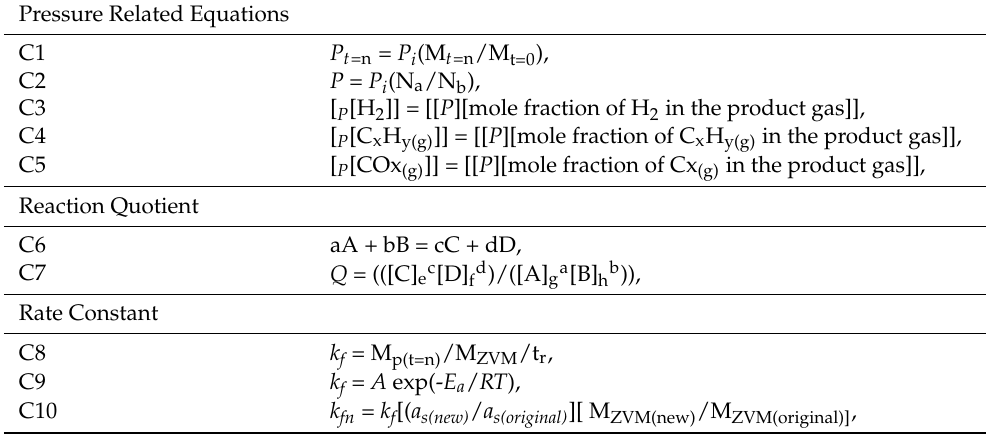
Table 2. Pressure, reactant quotient and rate constant equations. N a = N 2(concentration in air)t=0 ; N b = N 2(concentration in the product gas)t=n ; M pt=n = moles of product in the gas body, at time t = n; M ZVM = Mass of ZVM in the retort, g L − 1 ; t r = trial duration, seconds, s; R = gas constant, J T − 1 mole − 1 ; T = temperature, K; E a = activation energy, J mol − 1 , A = Avogadro’s